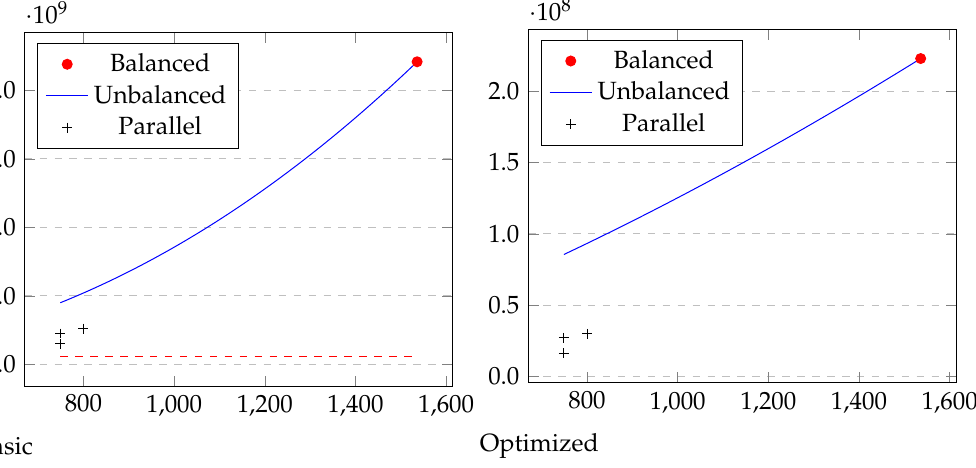
Figure 5. Decryption complexity versus λ p for λ n =